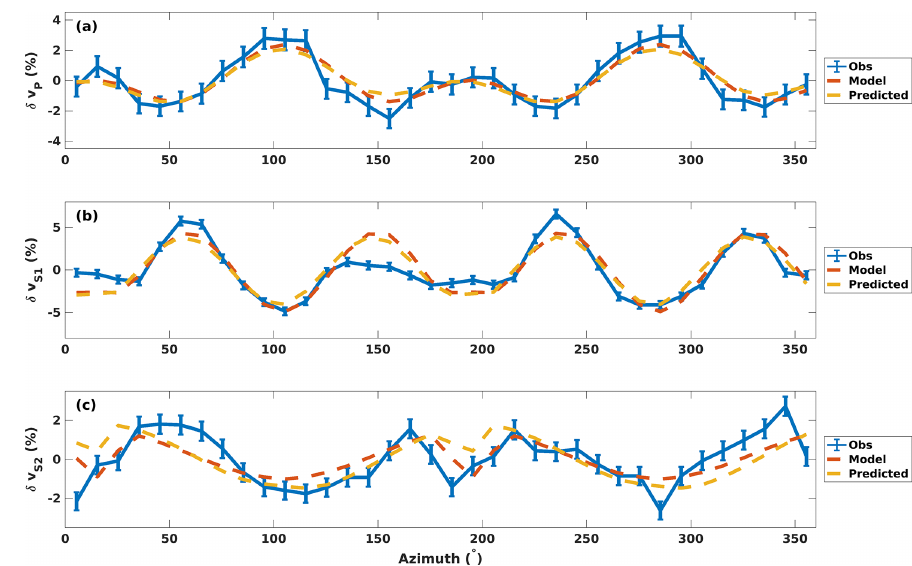
Figure 12. Observed, modelled and CPO-predicted anisotropy for sample 003. (a) δv P ; (b) δv S1 ; (c) δv S2 .